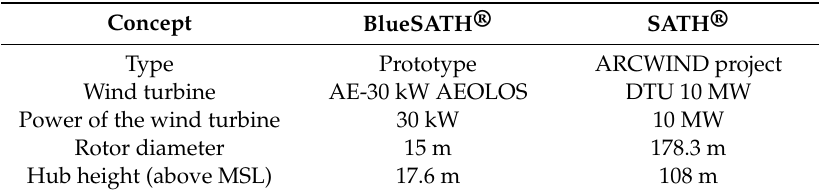
Table 1. Technical data of the BlueSATH ® platform [34].